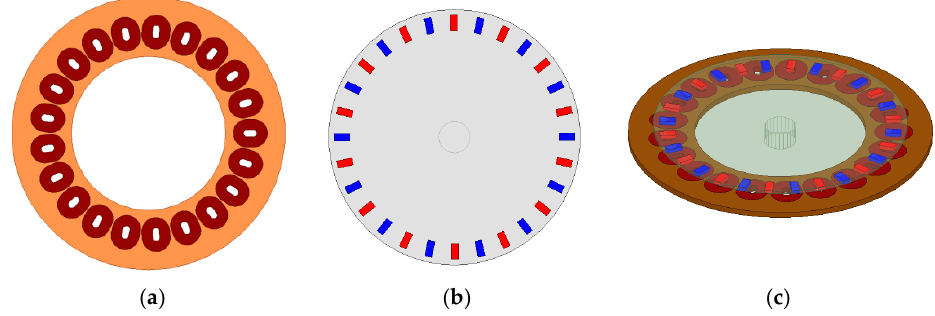
Figure 1. Axial Flux Permanent Magnet (AFPM) generator model with ANSYS Maxwell program: ( a ) stator disc with non-overlapping windings; ( b ) a rotor disc with basic (simple) Permanent Magnet (PM) arrangement; ( c )